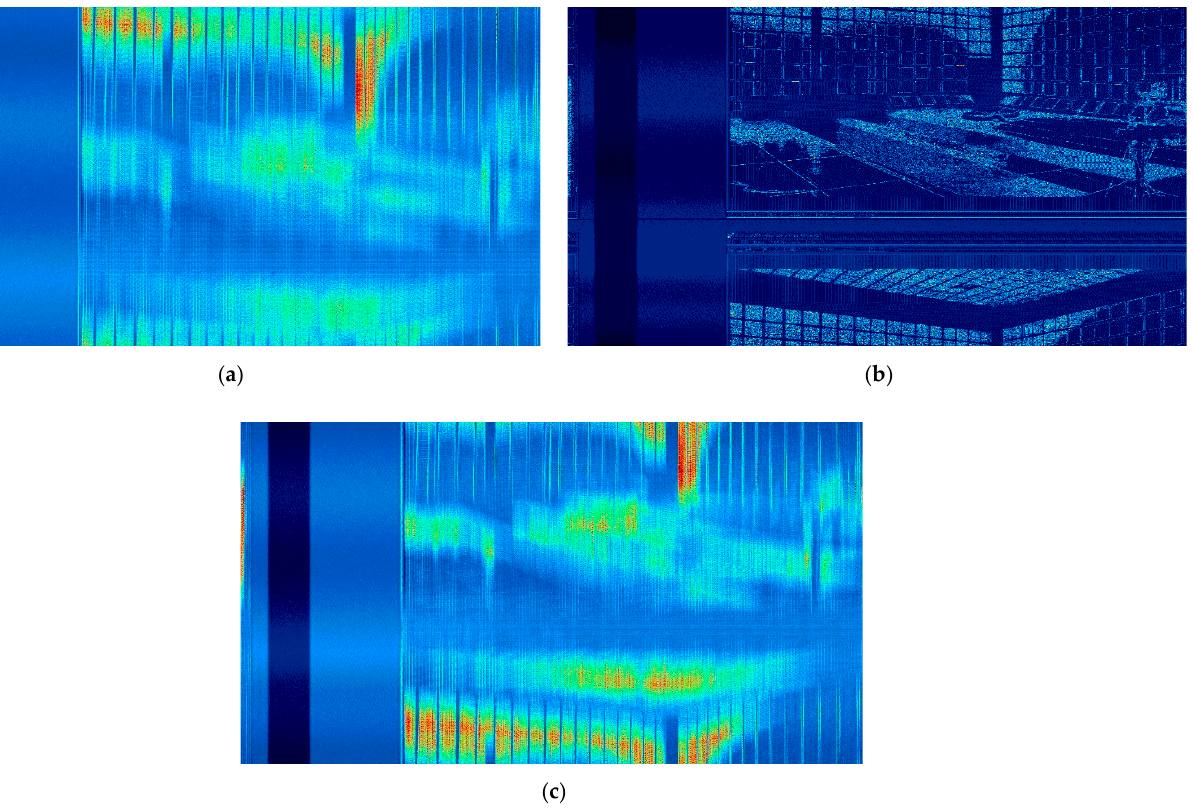
Figure 6 . Examples of incorrectly determined number of lines of the reconstructed images: ( a ) too few lines, ( b ) correct number of lines, ( c ) too many lines—30-fold summation of the reconstructed image for the revealing emission signal measured at the frequency 𝑓 (cid:3042) = 1334 MHz , band reception 𝐵𝑊 = 50 MHz , primary image displayed in the mode of 1280 × 1024/60 Hz, DVI standard, image in greyscale.